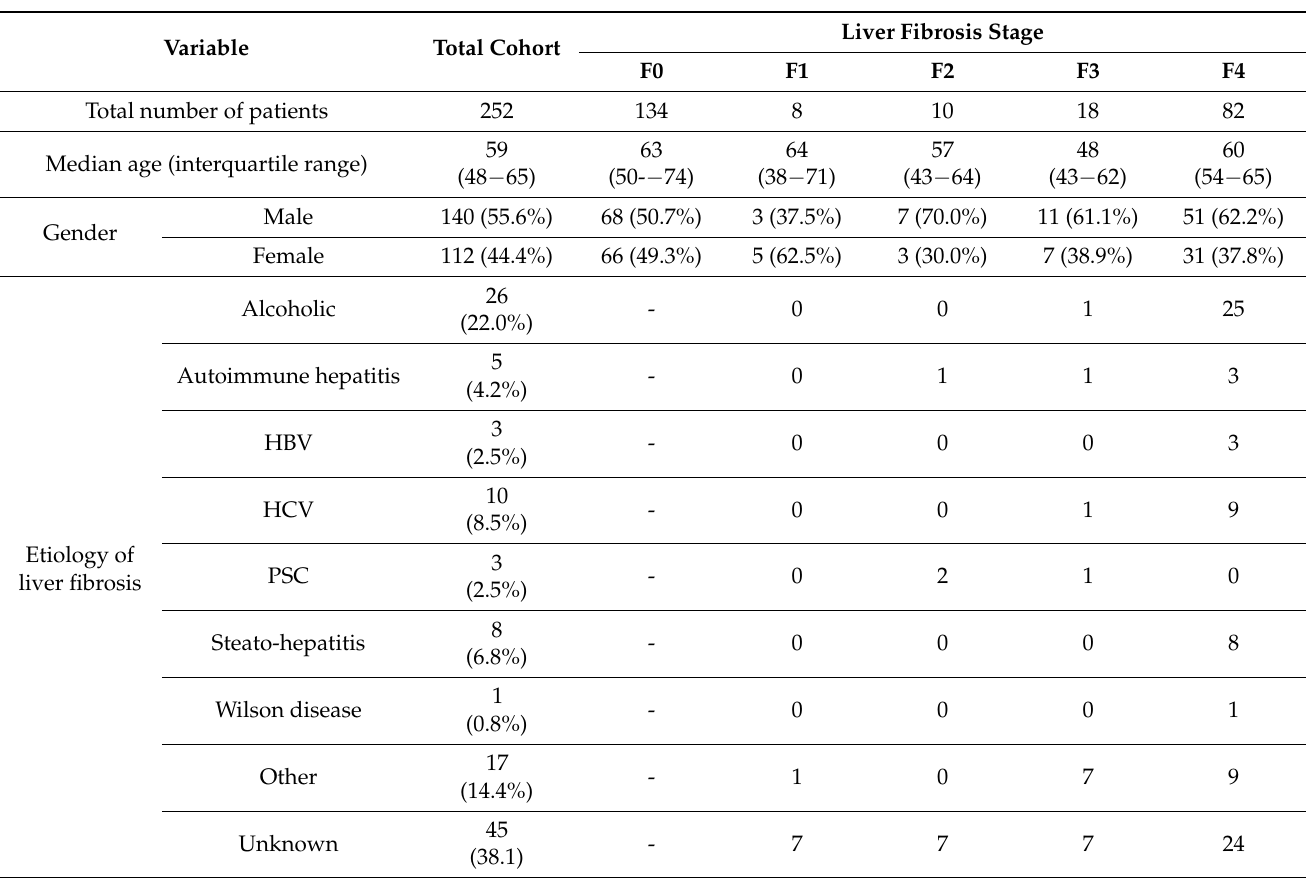
Table 1. Demographics of the study